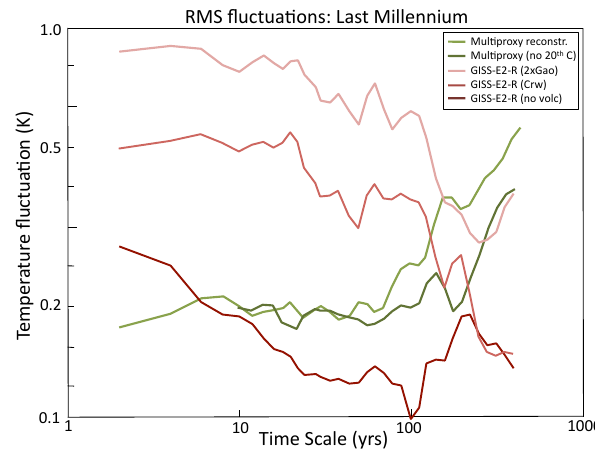
Fig. 12. rms fluctuations of instrumental and palaeo-climate recon- structions compared to drift-corrected simulations of the Northern Hemisphere land temperature for the period 1500–1900. 2xGao and Crw refer to GISS-E2-R simulations using the (2x) Gao et al. (2008) and Crowley and Unterman (2013) reconstructions of volcanic forc- ing. The multiproxy reconstruction used is an average of three NH estimates, and the rms fluctuations are separately shown for the pe- riods 1000–1900 and